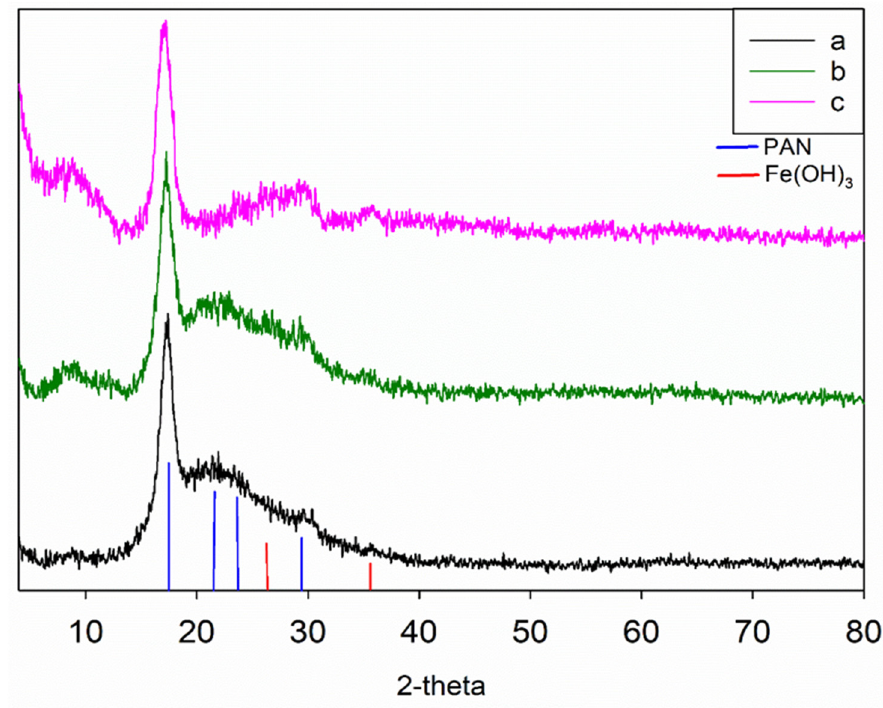
Figure 5. Diffractograms of the sorbents: (a)—Fe-NH, (b)—Fe-SF, (c)—Fe-H. The IR spectra of the sorbents are shown in Figure 6.